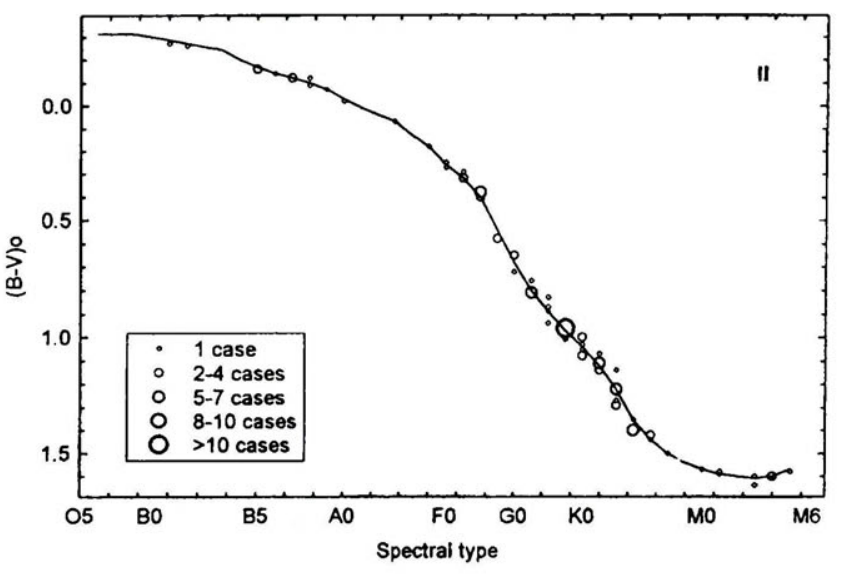
Fig. 11. Intrinsic color indices (ß-F)o for luminosity II stars.